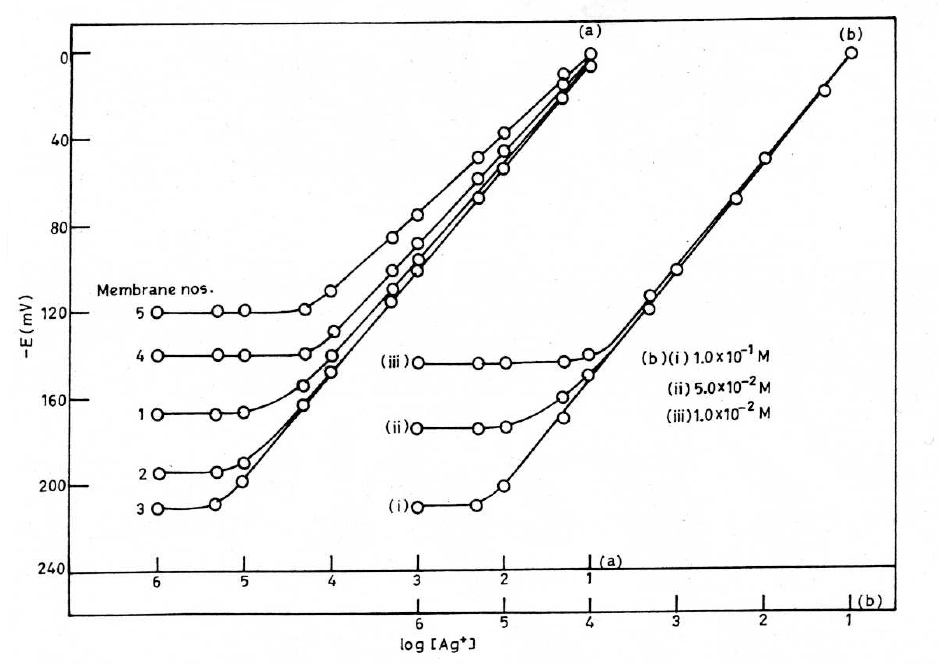
Figure 1. (a) Potential vs –log[Ag + ] plots of different compositions. (b) Potential vs – log[Ag + ] plots of varying compositions of internal reference